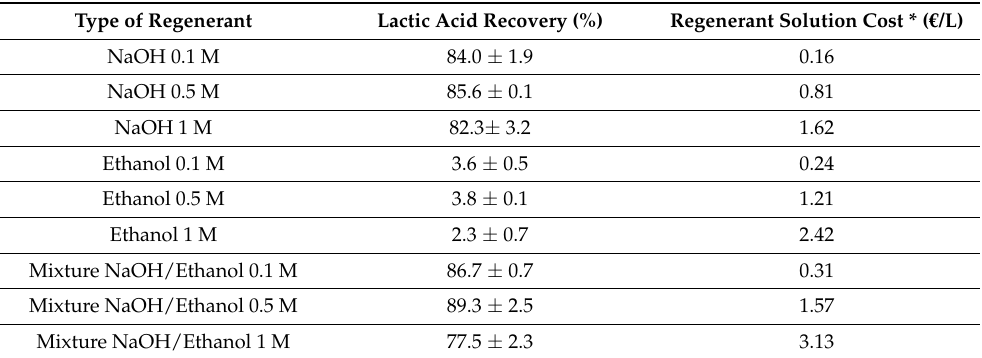
Table 7. Lactic acid recovery as a function of the regenerant type and concentration, as well as its